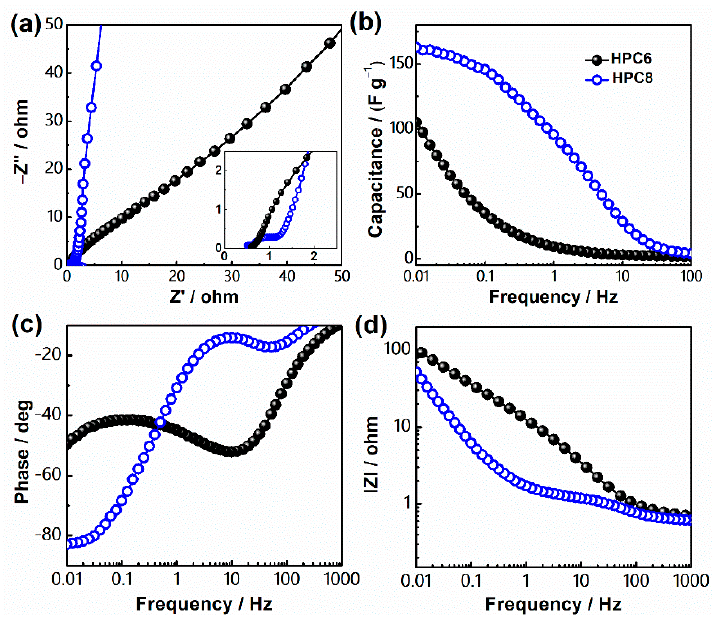
Figure 5. ( a ) Nyquist plot, frequency dependence of ( b ) capacitance, ( c ) phase angle and ( d ) |Z| for HPCs in H 2 SO 4 electrolyte.